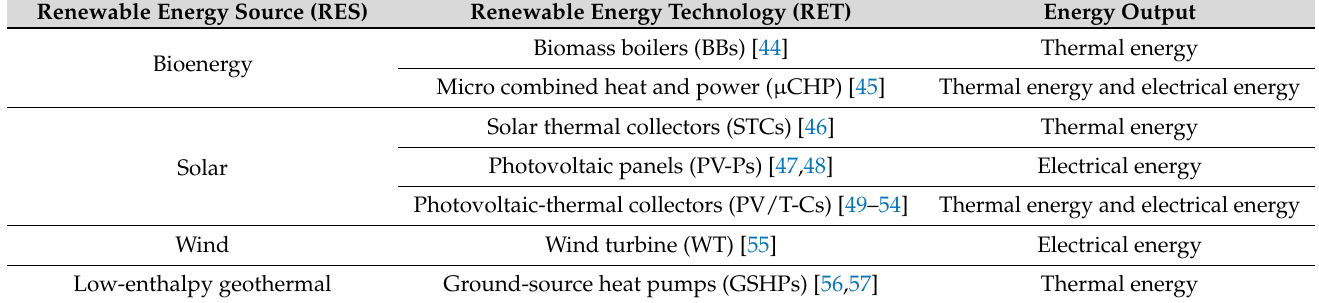
Table 1. RETs applicable to the residential sector for energy